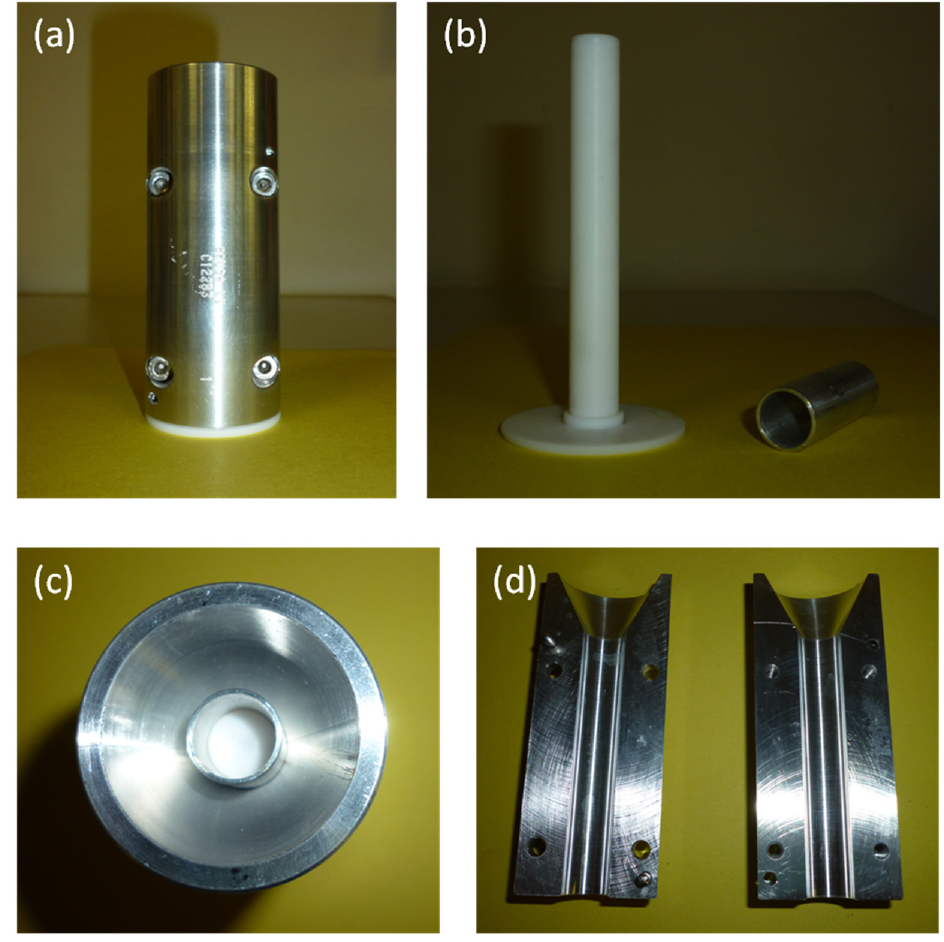
Figure 1. Mold designed for the production of tubular scaffolds by freeze-drying. ( a ) Complete mold; ( b ) internal mandrel and bush; ( c ) view from the top; ( d ) external chamber, open. Since all the three biopolymers are soluble in water, scaffolds were cross-linked by treatment with EDC, for the stabilization of both protein components, and with a CaCl 2 solution, for the ionic cross-linking of the polysaccharide